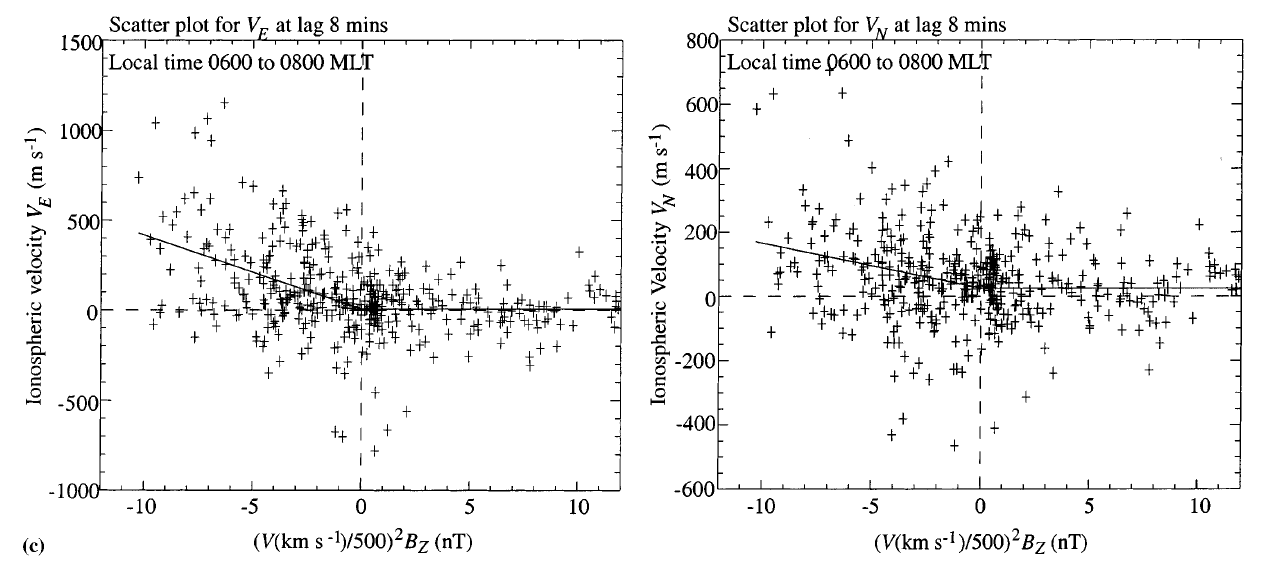
Fig. 4. c As for a except for the 2-h interval centred on